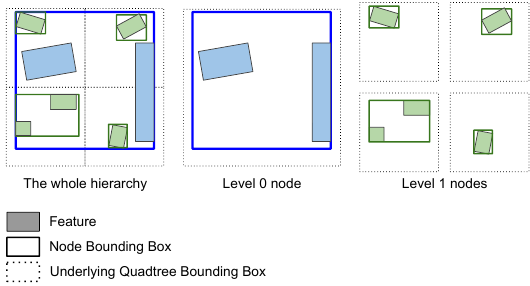
Figure 2: A 2D representation of the bounding box hierarchy